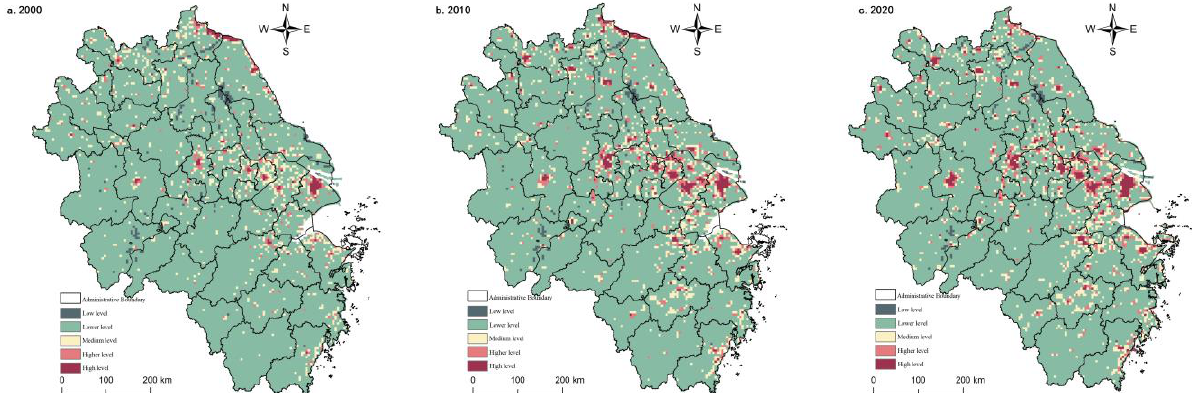
Figure 4. Spatial pattern of non-agricultural production functions in the Yangtze River Delta